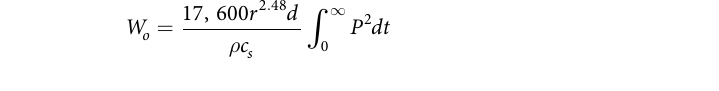
with R 2 correlation coefficient = 0.975. Solving for r = r o at which W = W o = 112 J, the total energy deposited, gives